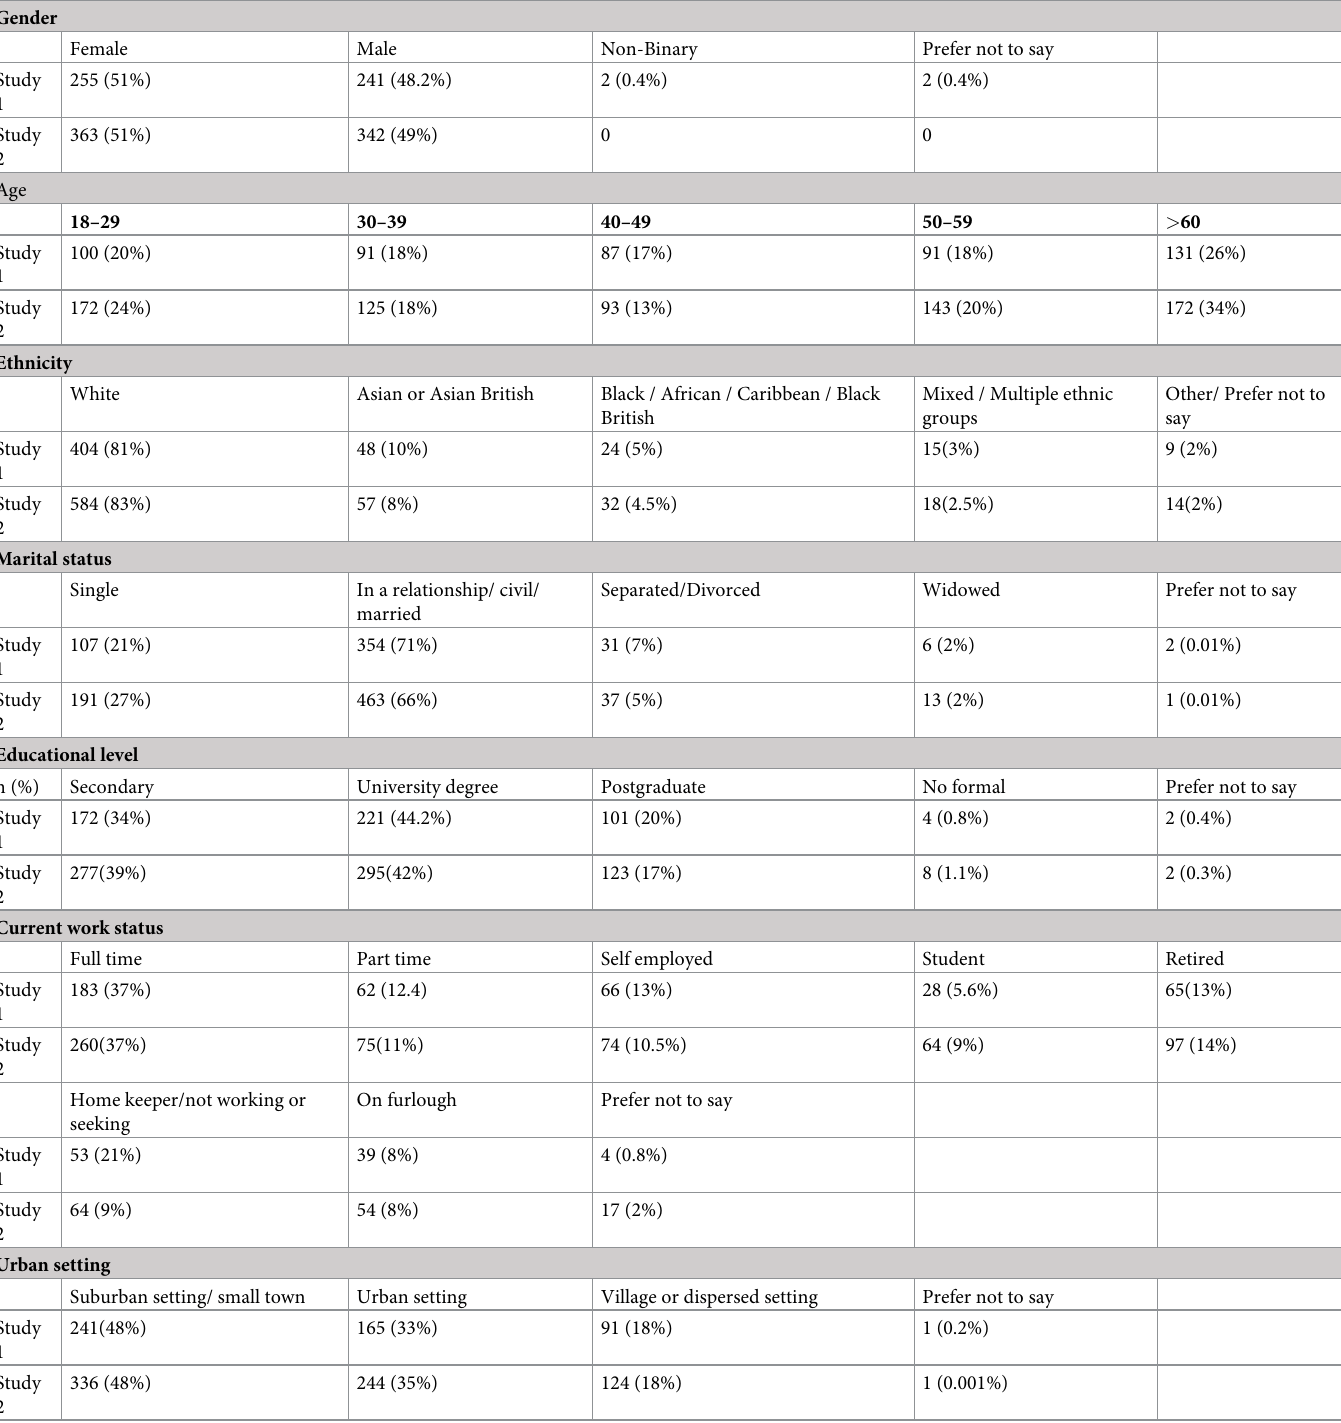
Table 1. Sample demographics for Study 1 (N = 500) and Study 2 (N =